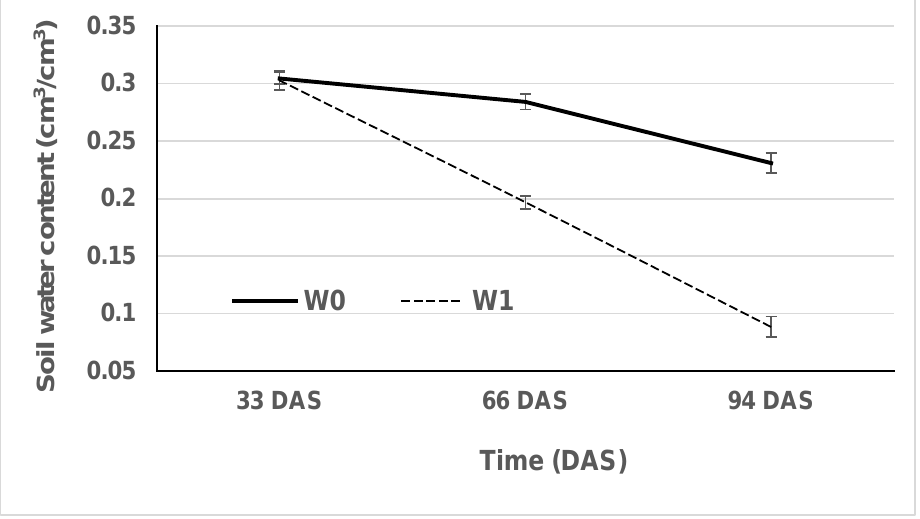
Figure 3. Average volumetric soil water content (cm 3 /cm 3 ) at 33 days after sowing (DAS), 66 DAS ( p < 0.001), and 94 DAS ( p < 0.001) at the Laleia site in 2019. W0, well-watered control; W1, water withheld from flower initiation to maturity. Bars indicate the standard error of